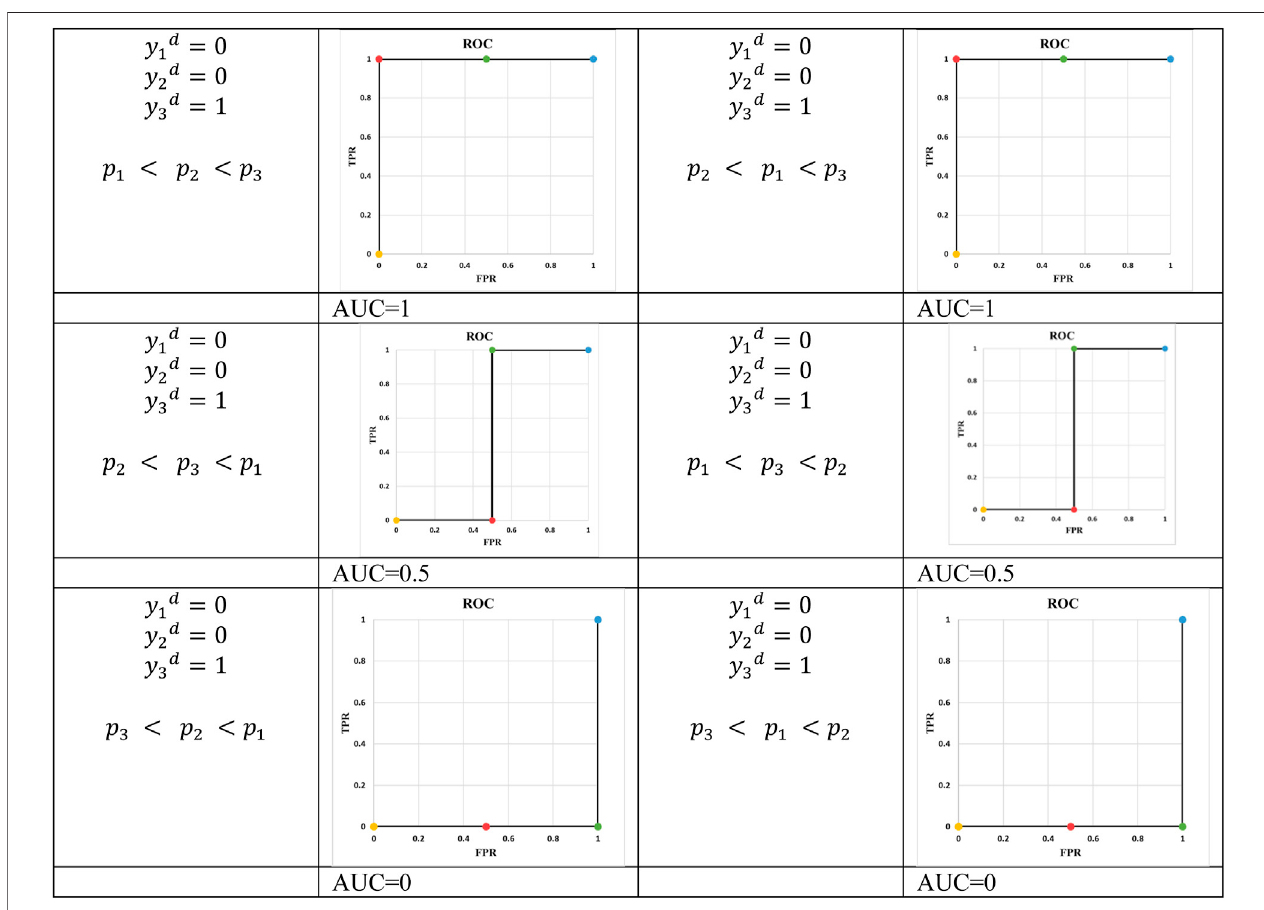
FIGURE 5 | ROC curves for N (cid:1) 3, two actual negative and an actual positive.